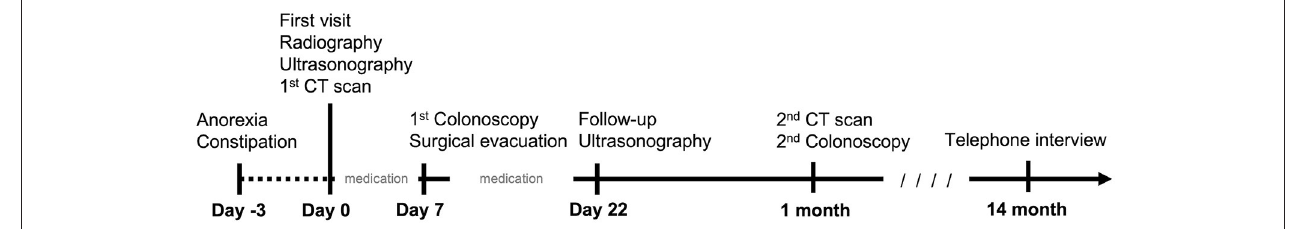
FIGURE 5 | A brief timeline of the medicine intervention in the cat. Clinical signs presented 3 days prior to first visit. Radiography, ultrasonography, and CT examination were performed on the same day of the first visit. Palliative medication was administrated for 7 days. The surgical intervention was performed 7 days later. Post-operative medicine was administrated for 2 weeks. The patient revisited on day 22. A follow-up CT scan and colonoscopy were conducted 1 month later. After 14 months, a final telephone interview was